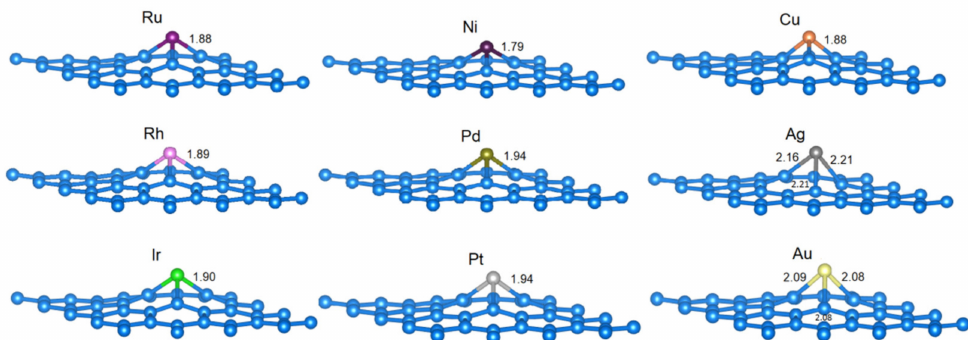
Figure 1. The most stable structures of the studied C 31 M systems (M is labeled for each structure), with C − M bond lengths given in Å (if all C − M bonds are of equal length, only one such length is indicated). Structural models were made using VESTA